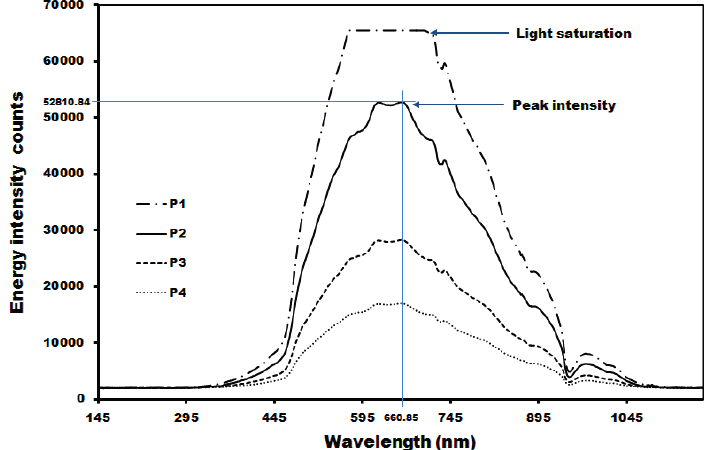
Figure 10. Changes in energy intensity in the red pepper powder spectrum due to differences in the probe